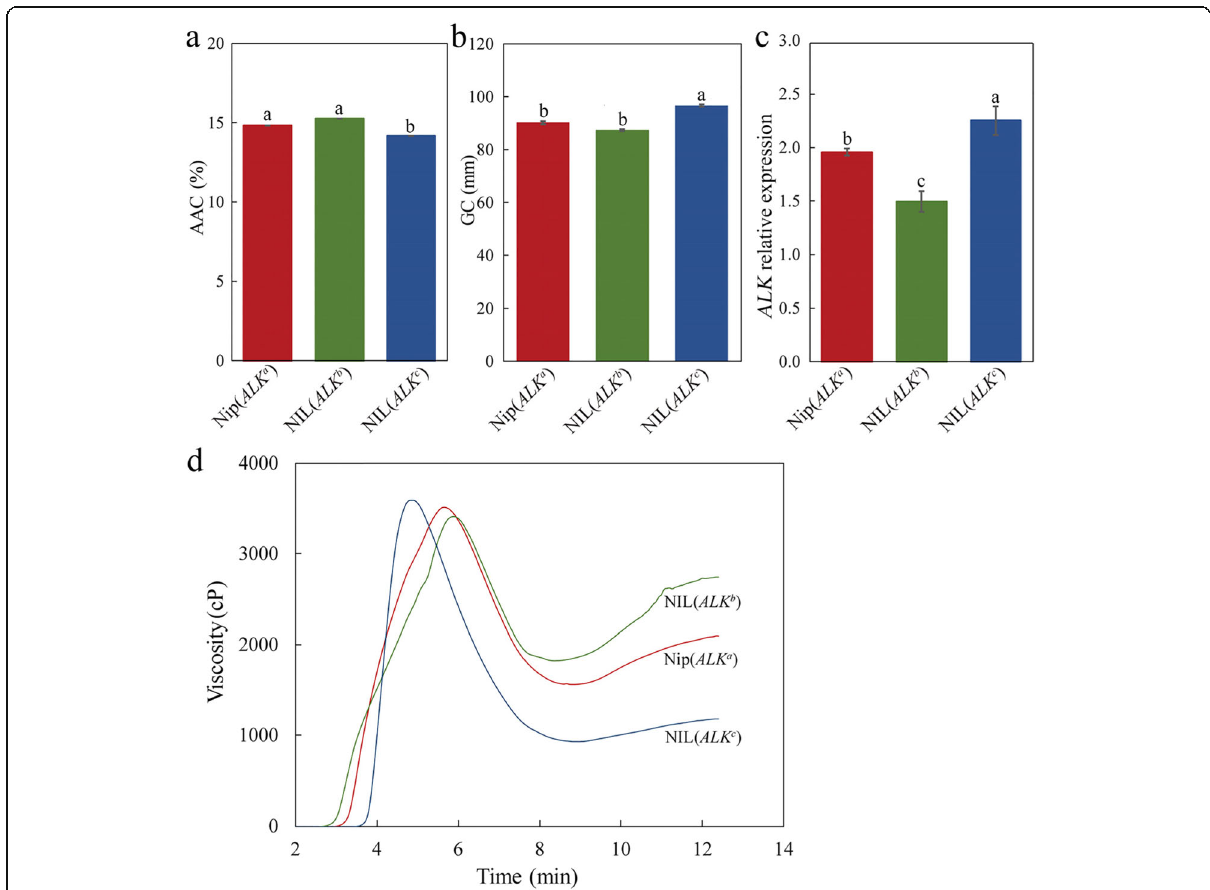
Fig. 4 Physicochemical characteristics of mature grains from different near-isogenic lines (NILs) and expression levels of different ALK alleles in developing seed. a Apparent amylose content (AAC) in mature rice grains. b Gel consistency (GC) in mature rice grains. c Transcriptional levels of ALK gene in developing seeds at 15 days after flowering (DAF). d Rapid Visco Analyzer (RVA) curves of rice flours from mature rice grains. Error bars are mean ± s.d. (n = 3), and the small letters above error bars indicate significant differences among subpopulations ( P <